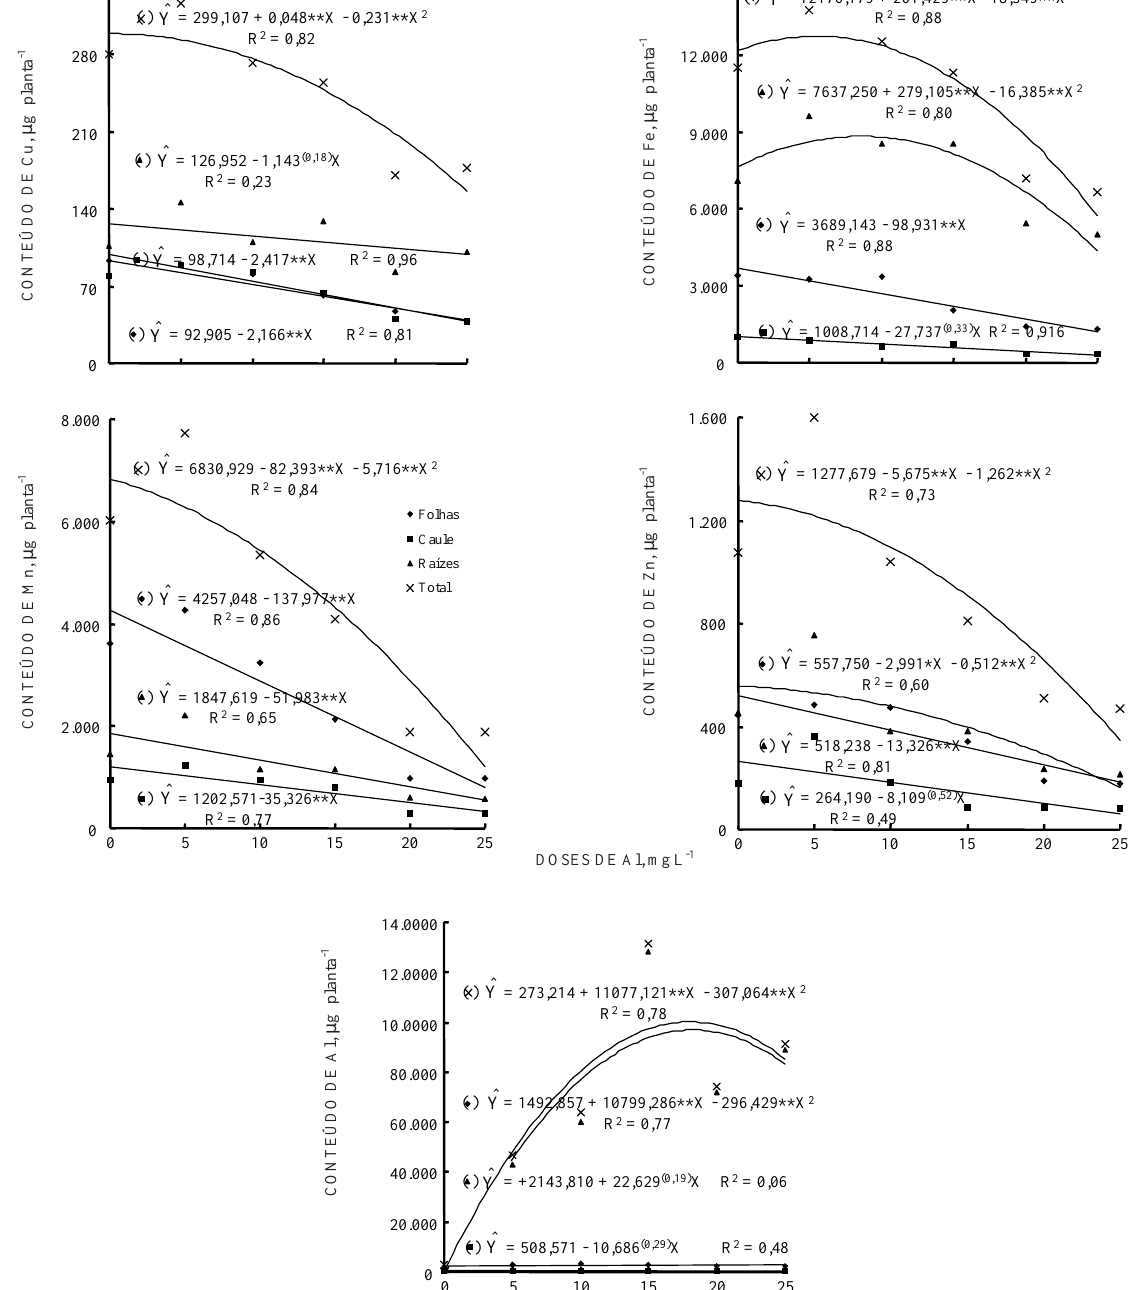
DOSES DE Al, mg L